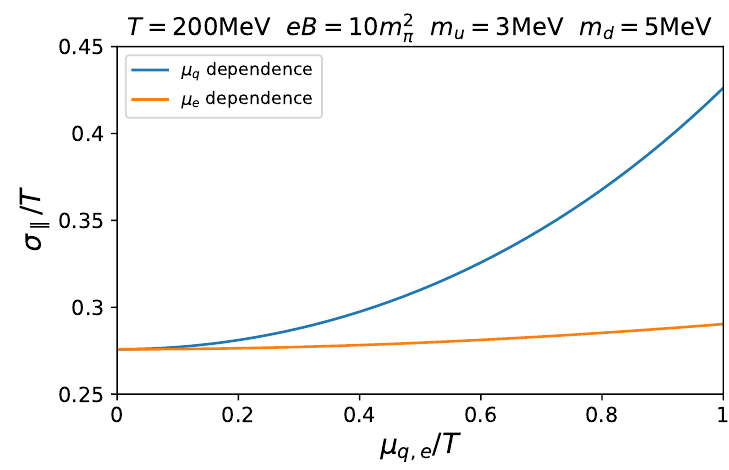
Figure 7 . Chemical potential dependence of the longitudinal electric conductivity for two (cid:13)avor case. The upper line is for the quark chemical potential, while the lower one is for the electric chemical potential coupled to the electric